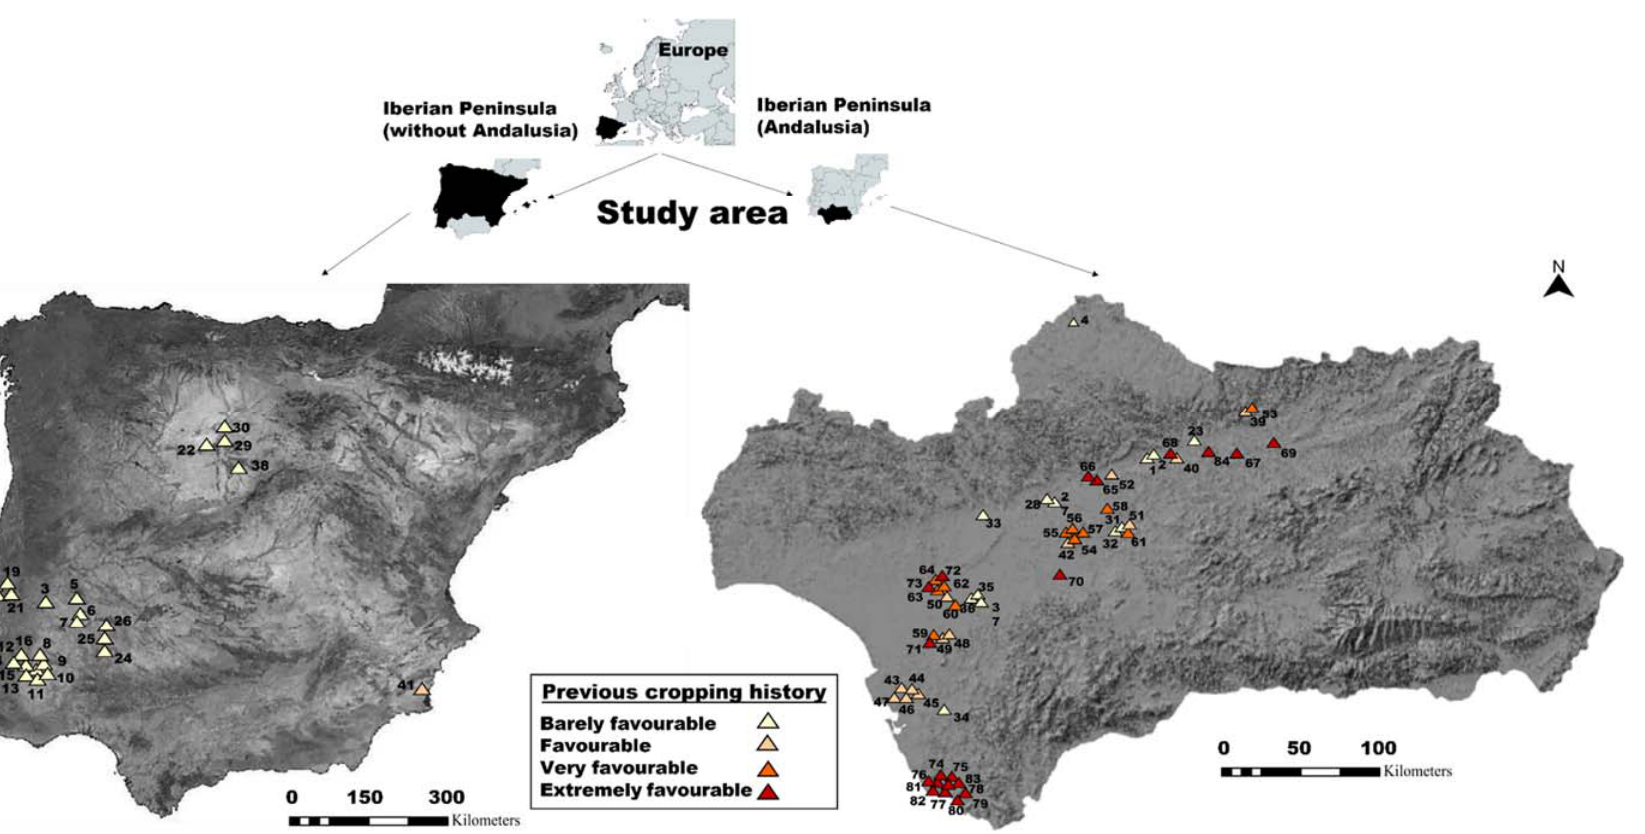
Figure 1. Geographical location of the plots sampled in the Iberian Peninsula. The numbers are the references of the samples (see Table S1 for details). The administrative boundaries were obtained from public spatial data layers of the Environmental Information Network of Andalusia (https://descargasrediam.cica.es/repo/s/RUR?path=%2F) and the Spanish National Geographic Institute (http://www.ign.es). The digital elevation models shown as base maps for the Iberian Peninsula without Andalusia and for Andalusia were downloaded, respectively, from a public database available at (http://www.juntadeandalucia.es/institutodeestadisticaycartografia/prodCartografia/bc/mdt.htm) and (https://www.idee.es:80/csw-inspire-idee/static/api/records/spaignMosaicoLandsat_Historico). Date accessed: 1 July 2021. All the data are compatible with the CC ‐ BY 4.0 license.2.1. Soil sampling and characteristics of surveyed fields.